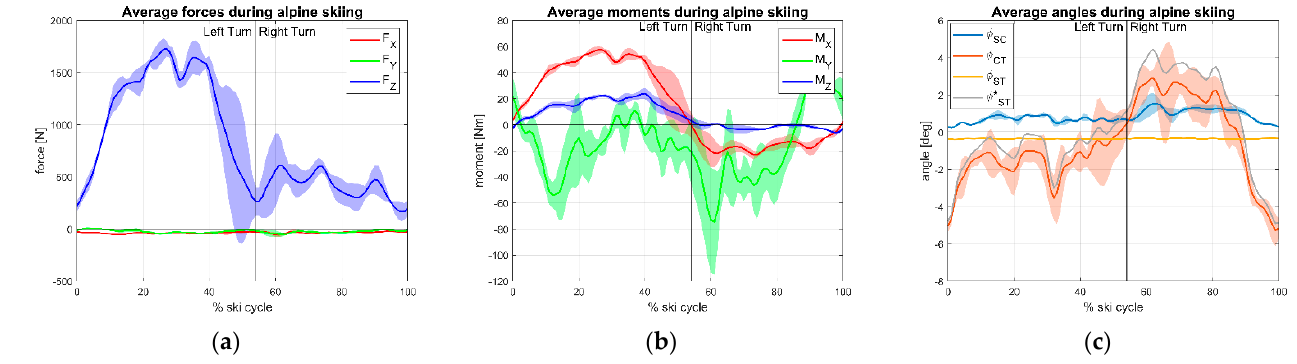
Figure 6. Ground reaction forces and kinematics during ski-touring session: ( a ) uphill forces; ( b )